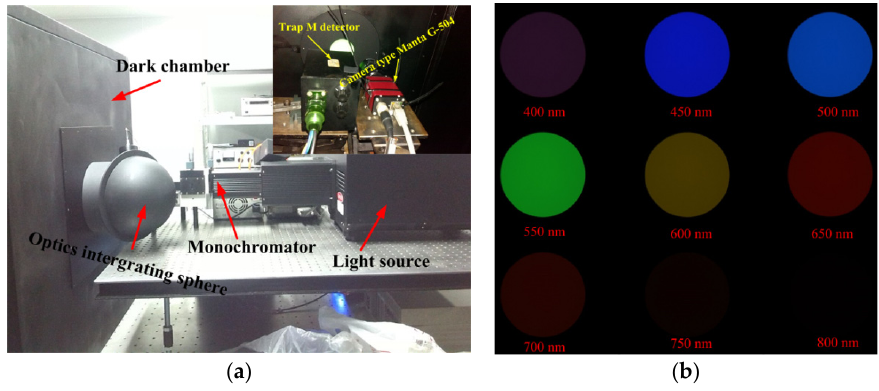
Figure 8. ( a ) Camera calibration of relative spectral response setup; and ( b ) Typical monochromatic radiation images.